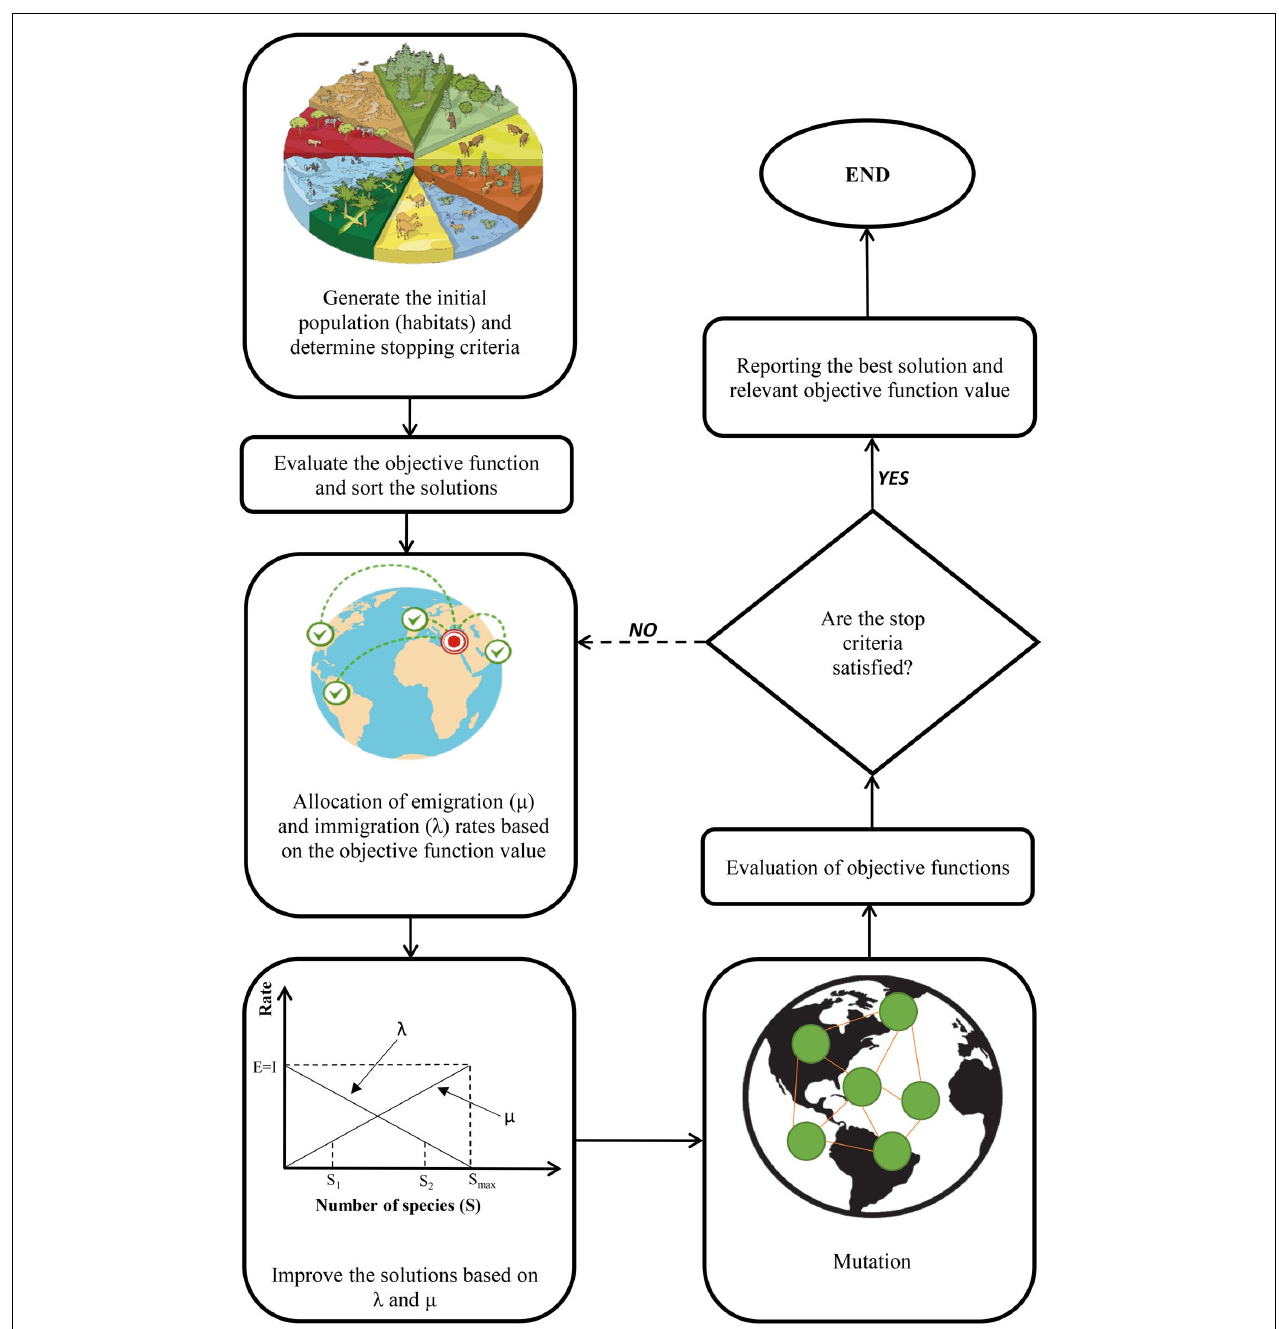
FIGURE 6 | A schematic representation of biogeography-based optimization (BBO)